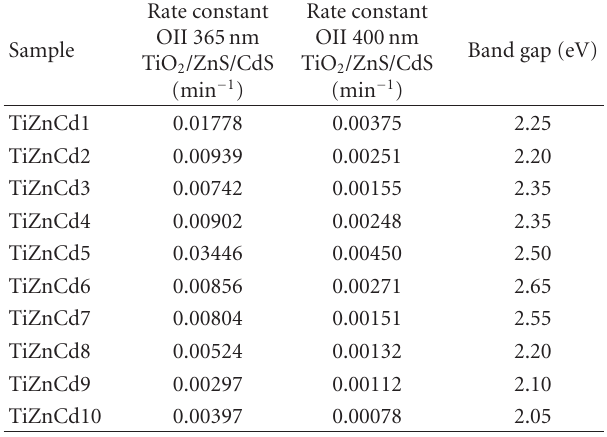
Table 4: Rate constant of Orange II degradation and band-gap